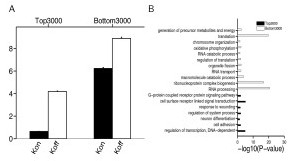
Functional enrichment of noisy genes showing distinctive bursting patterns of gene expression in mouse ES cells. (A) The mean of kon,i and koff,i (± S.E.) for the top and bottom 3,000 genes sorted by koff,i/ kon,i. (S.E. = standard error). (B) The Benjamini corrected P values of the 18 GO terms enriched in the top or bottom 3,000 genes. GO, gene oncology.